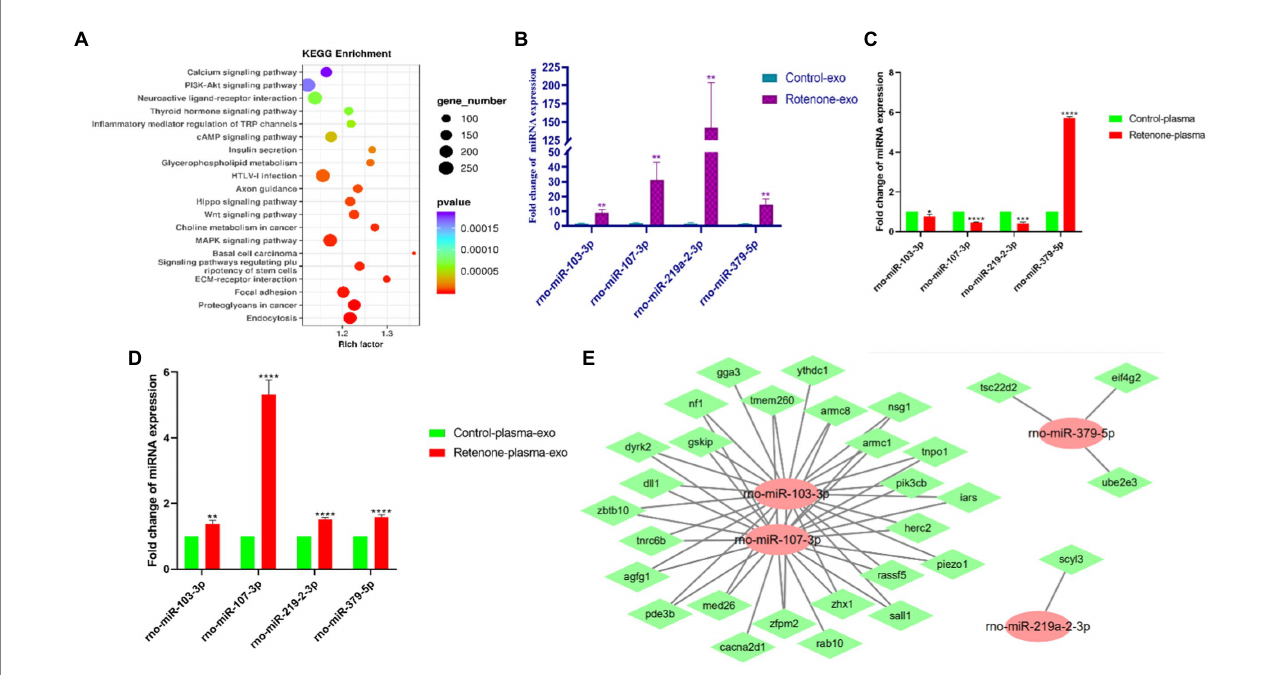
FIGURE 5 Validation of differentially expressed candidate miRNAs. (A) Kyoto Encyclopedia of Genes and Genomes (KEGG) pathway analysis of the top 25 KEGG pathways of obviously DEGs in the sham and PD groups ( p < 0.05 and FDR < 0.05), (B) The expression levels of four midbrain tissue–derived sEVs (bdsEVs) miRNAs were analyzed in Parkinson’s disease (PD) ( n = 3) and sham control ( n = 3) using RT-qPCR, (C) The expression levels of the four miRNAs in plasma of Parkinson’s disease (PD) ( n = 3) and sham control ( n = 3), (D) The expression levels of the four miRNAs in sEVs derived from plasma of Parkinson’s disease (PD) ( n = 3) and sham control ( n = 3), and (E) The target gene predictions of the four bdsEVs miRNAs (rno-miR-103-3p, rno-miR-107-3p, rno-miR-219a-2-3p, and rno-miR-379-5p) by Targetscan (Total context++ score < − 0.3), miRDB (Target Score > 75) and miRanda (Total score > 150, Total energy < − 20). For all quantitative/statistical analysis, * p < 0.05; ** p < 0.01; *** p < 0.001, and **** p < 0.0001. All data are presented as means ± SEMs. sEVs, small extracellular vesicles; RT-qPCR, reverse-transcription quantitative polymerase chain reaction; miR,